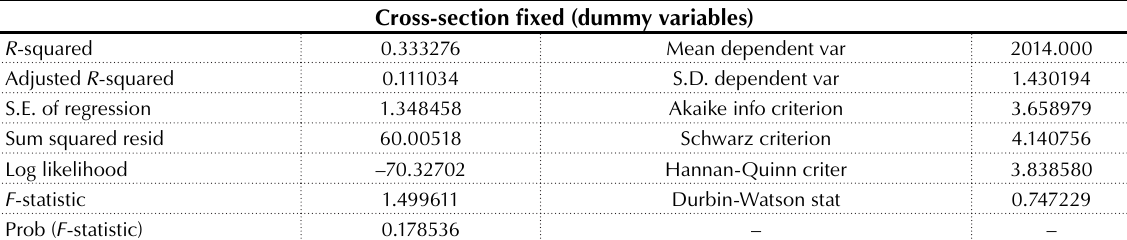
Source: Results of panel data regression output.